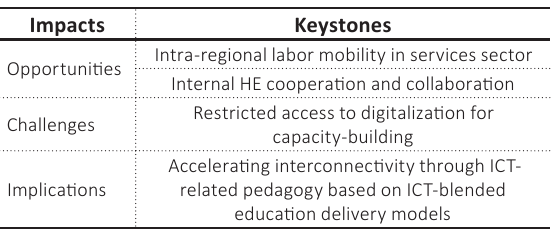
Table 8. Opportunities, challenges, implications for